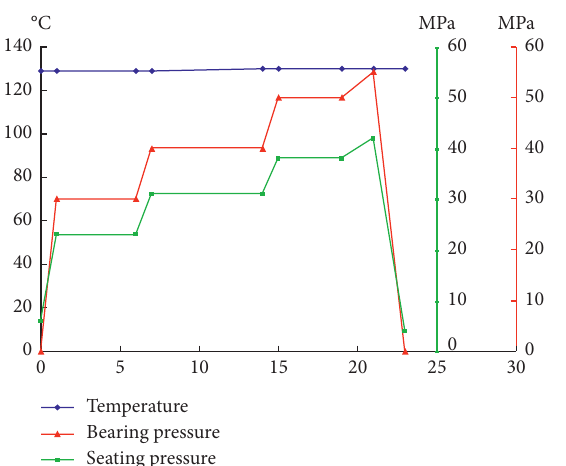
Figure 25: Change curve temperature, seating pressure, and bearing pressure.